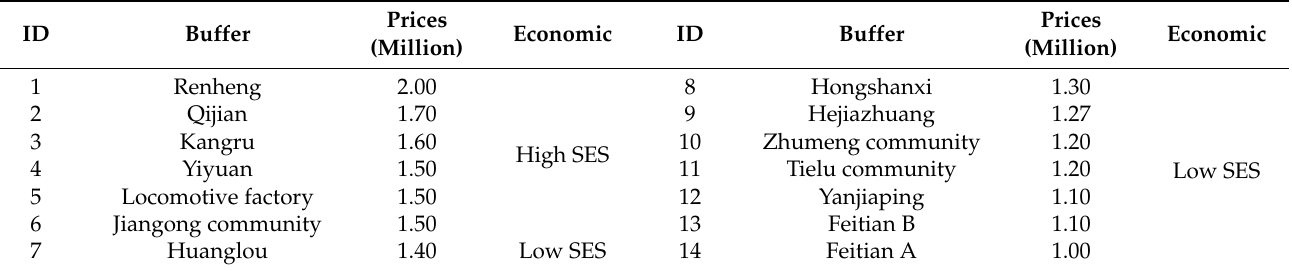
Figure 1. Research sample screening diagram. Table 1. Research regions.